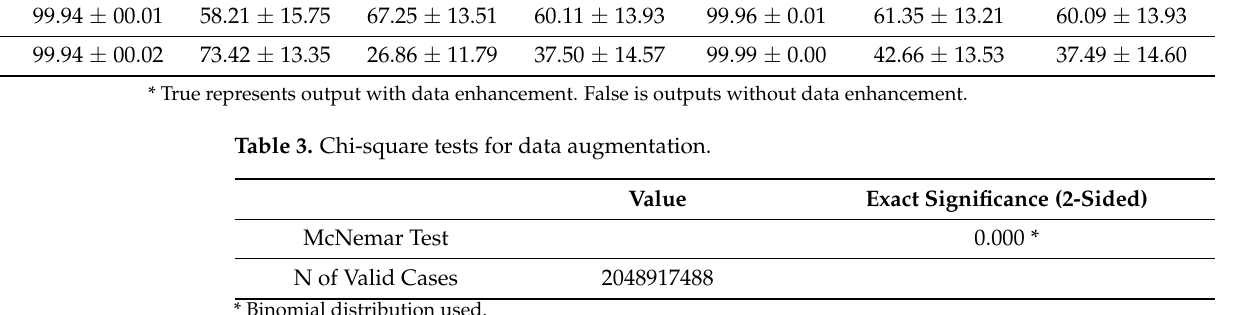
Table 2. Comparison of the segmentation with or without data enhancement (compared with the manual ground truth). ACC (%)